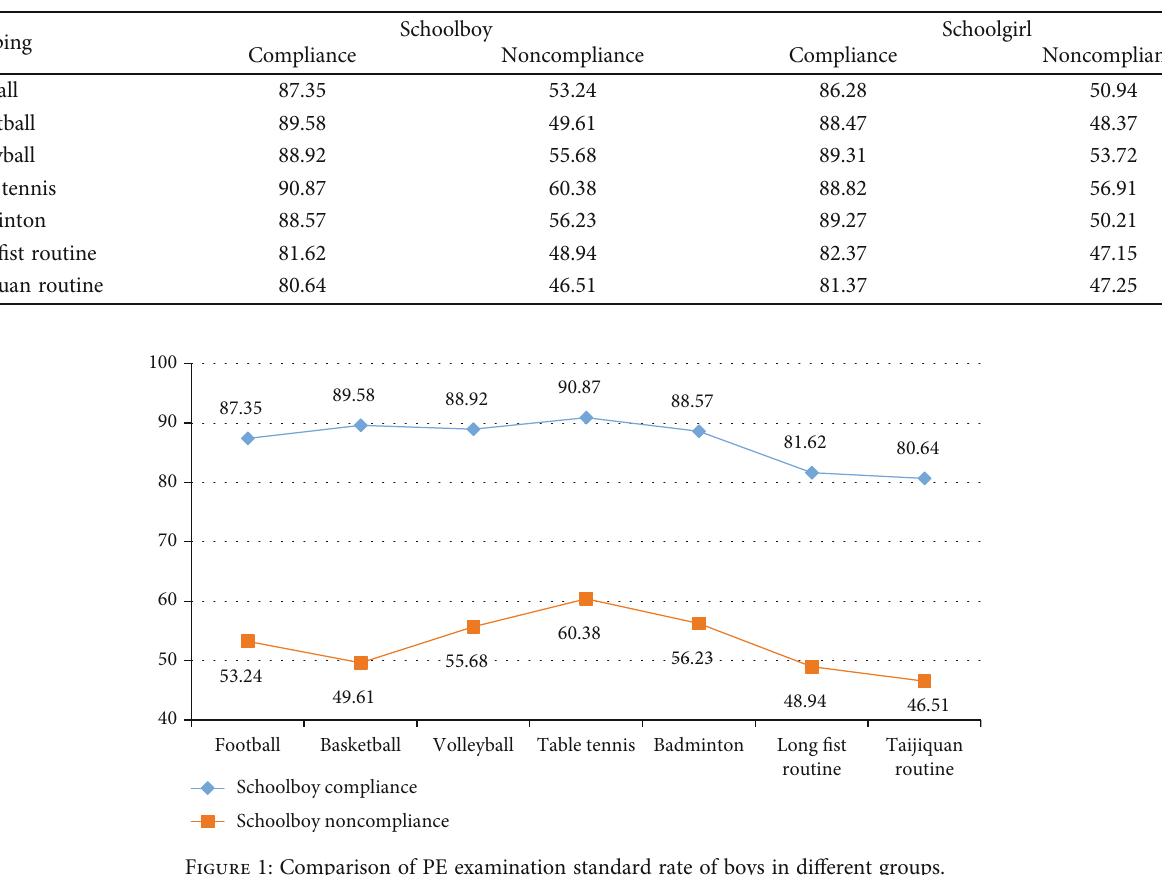
Table 1: Comparison of PE examination standard rate of students in di ff erent groups.